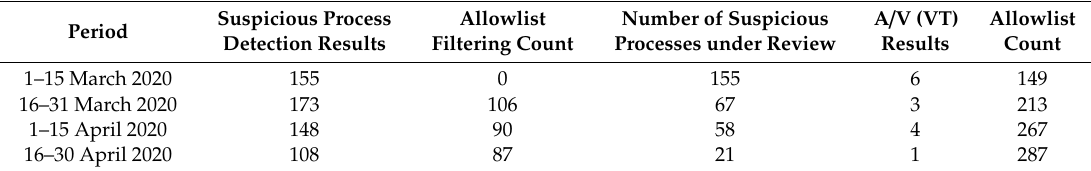
Table 10. Example of reduction of review targets through allowlist operation.